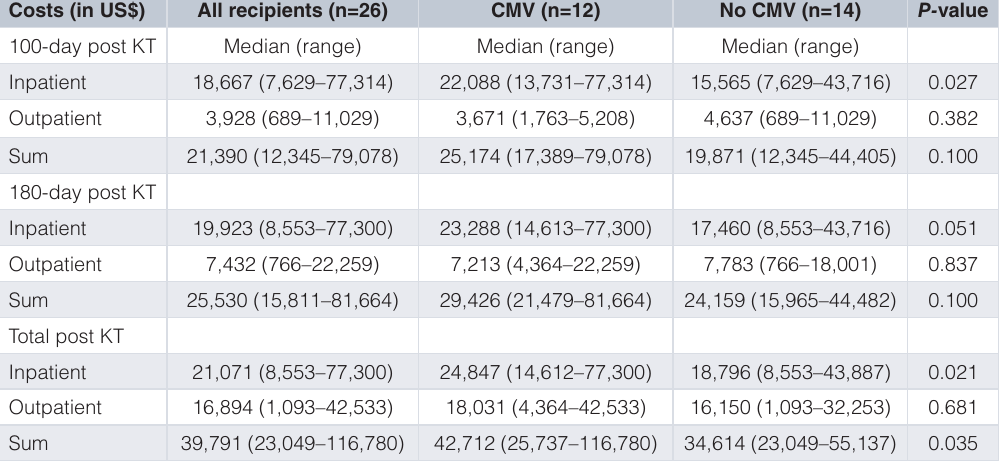
Table 3. Cost-outcome of ATG-treated KT recipients with/without CMV reactivation/diseases (n=26). Costs (in